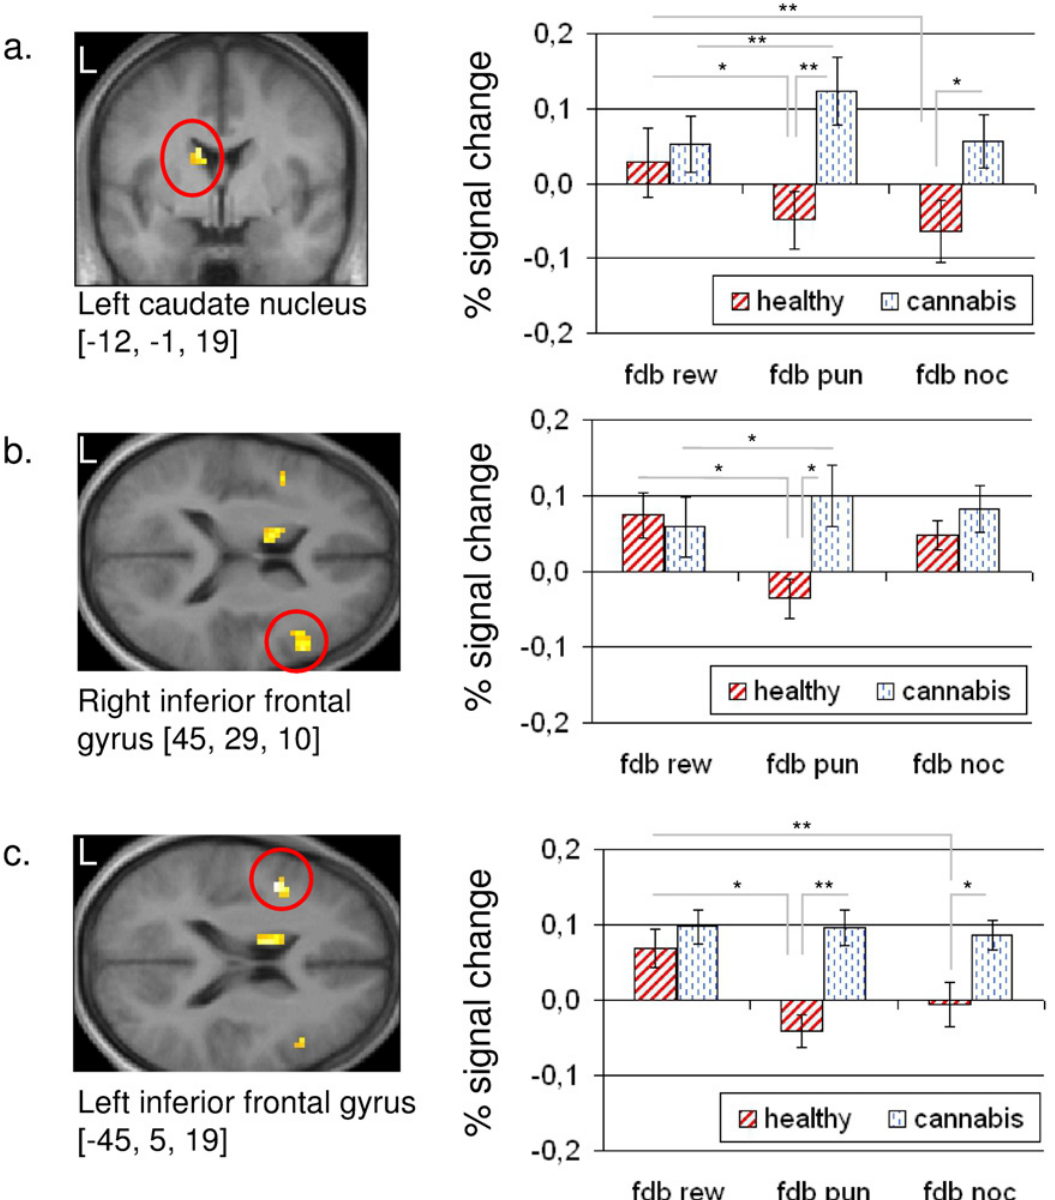
Fig 2. fMRI data regarding the feedback period. Statistical parametric maps representing the interaction contrast between ‘ group ’ (healthy, cannabis users) and ‘ task feedback ’ (fdb rew, fdb pun, fdb noc). Percent signal change derived from the (a) left caudate nucleus, (b) right inferior frontal gyrus, and (c) left inferior frontal gyrus. All regions of interest are circled in red. All statistical parametric maps are thresholded at p[uncorr] < 0.001 for k > 10. ** p < 0.01; * p < 0.05. Error bar represents SEM.